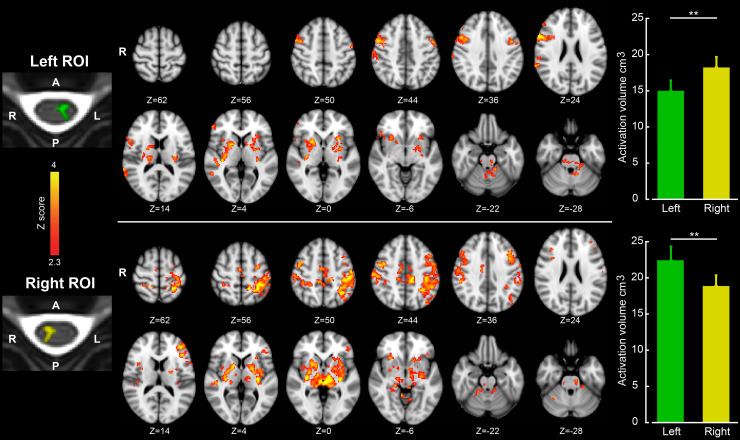
The spinal hemicords are preferentially connected to the contralateral cerebral cortex at rest.The left column shows the location of spinal ROIs, and on the right their associated brain functional connectivity maps are presented. As shown, the left (top row) and right (bottom row) spinal ROIs are mostly correlated with the right and left cerebral cortex, respectively. Color-coded activation maps indicate z-score values and are corrected for multiple comparisons using GRF, p < 0.05; Z-coordinates report MNI space. Bar plots show the average activation volume in the left (green) and right (yellow) brain hemispheres correlated to the left spinal ROI (top panel) and right spinal ROI (bottom panel). As shown, the left spinal ROI is correlated with a larger volume in the right brain hemisphere (**p < 0.01), while the right spinal ROI is correlated with a larger volume in the left brain hemisphere (**p < 0.01). Error bars represent SEM. The numerical data used in this figure are included in S1 Data. GRF, Gaussian random field; MNI, Montreal Neurological Institute; ROI, region of interest.